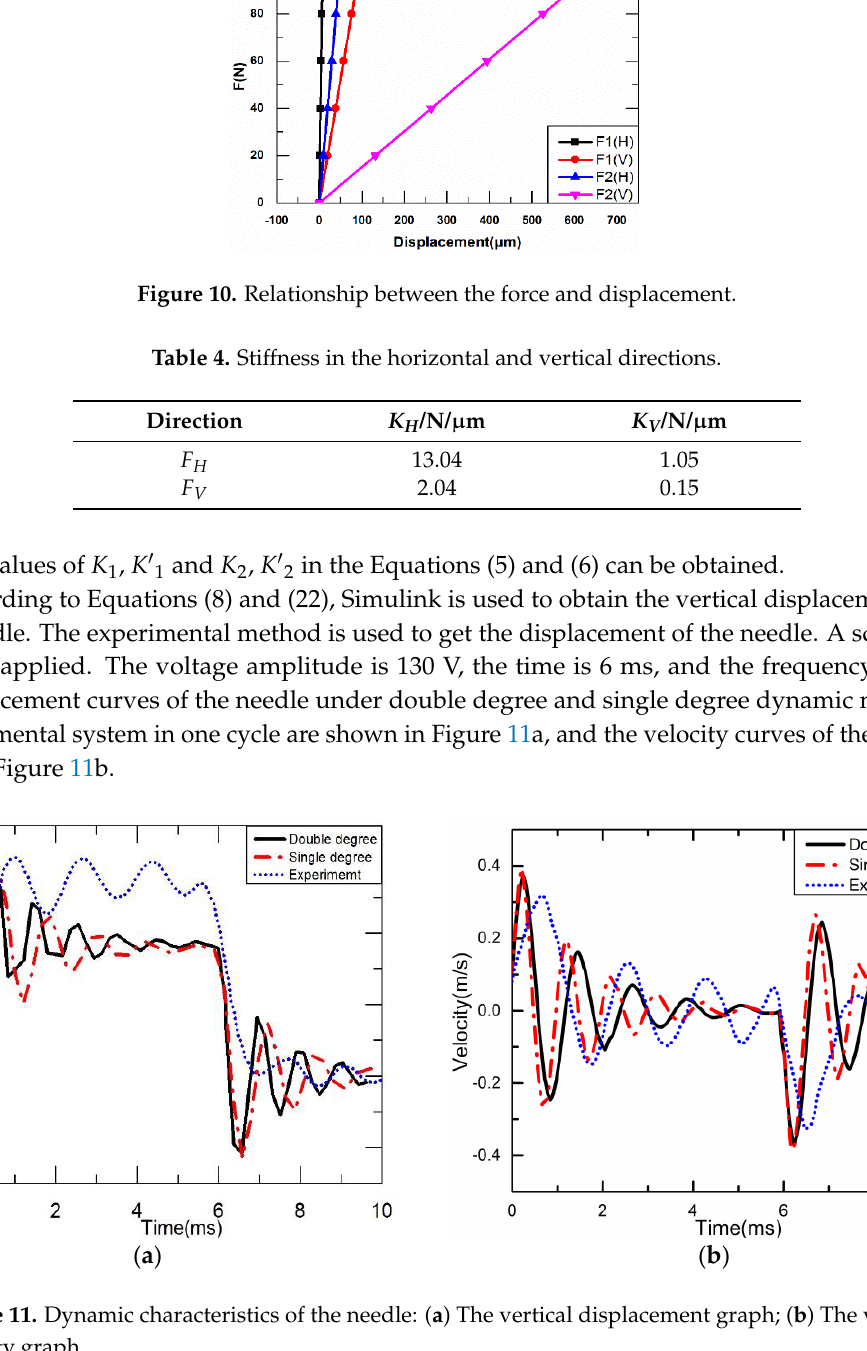
velocity graph. velocity